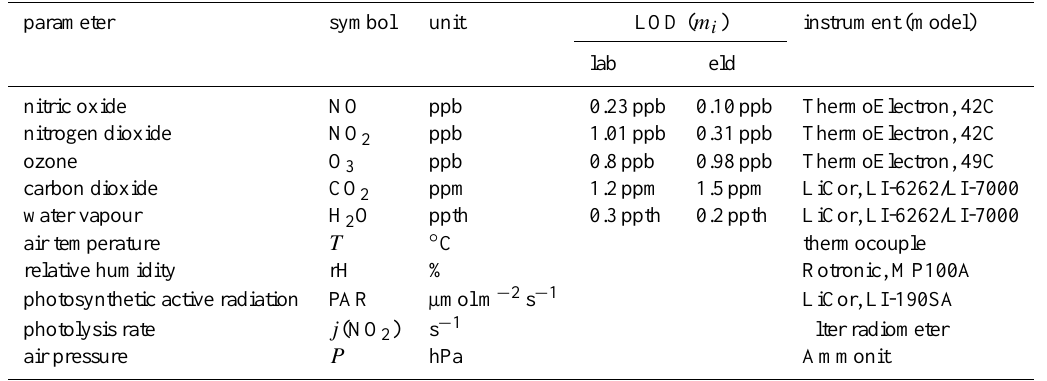
Table 3. Measured parameters and instrument specifications. Limit of detection (LOD ( m i ), 3 σ -definition) for the gas concentrations were determined under field and laboratory